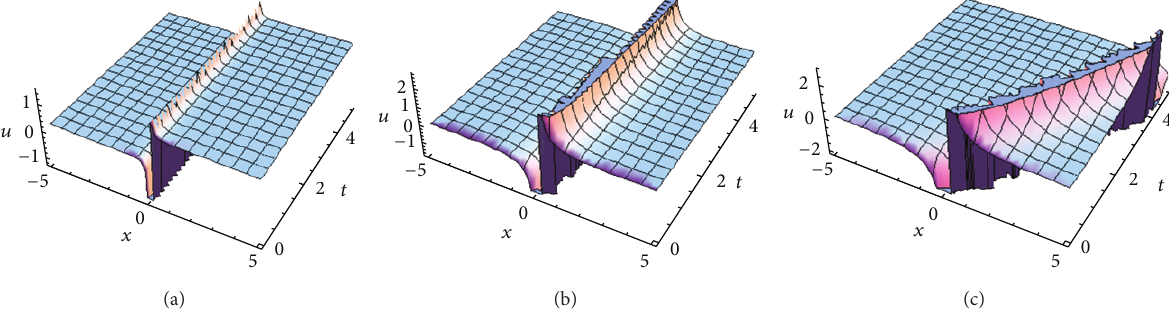
Figure 1: Graphics of the solution equation (27) corresponding to the values 𝛼 = 𝛽 = 0.01 , 𝛼 = 𝛽 = 0.25 , and 𝛼 = 𝛽 = 0.75 from left to right when 𝑘 = 𝑎 1 = 1 , 𝑎 2 = 0.1 , 𝛾 = −1 , −5 < 𝑥 < 5 , and 0 < 𝑡 < 5 .